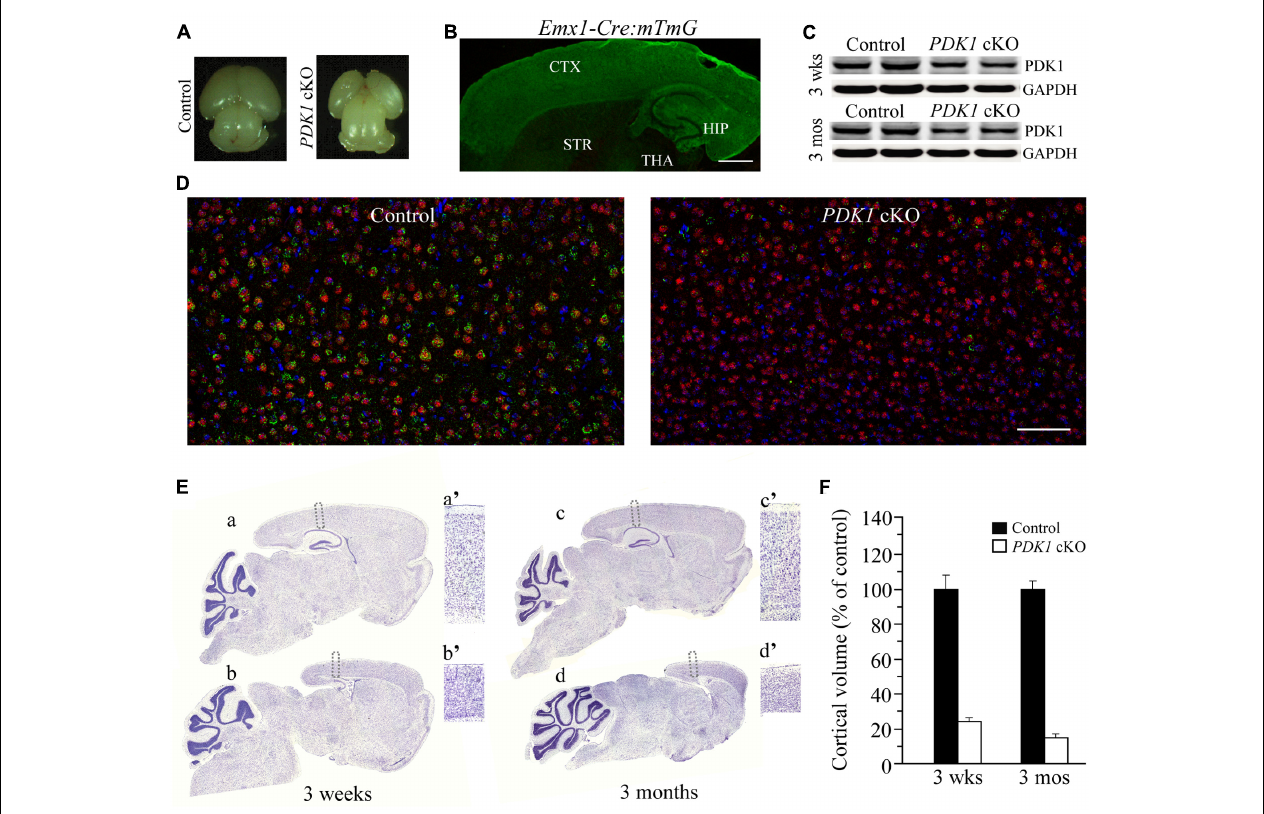
FIGURE 1 | Reduced size of the cortex in forebrain-specific PDK1 cKO mice. (A) Representative brain photos for a control mouse and a PDK1 cKO mouse at P0. (B) The expression pattern of GFP in the brain of a 3-week-old Emx1-Cre;mTmG mouse. GFP was mainly expressed in the cortex (CTX) and the hippocampus (HIP) but not the striatum (STR), the thalamus (THA), or the cerebellum. (C) Western analysis on PDK1. Cortical homogenates from mice aged at 3 weeks and 3 months ( n = 3–4/group/age) were prepared. There was significant difference on protein levels of PDK1 between control and PDK1 cKO mice (3 weeks: control = 100 ± 4.6%, cKO = 58.0 ± 5.8%; 3 months: control = 100 ± 3.5%, cKO = 60.3 ± 2.1%; p s < 0.005). GAPDH served as the loading control. (D) Double-immunostaining for NeuN/PDK1 in mice at 3 weeks of age. Most NeuN+ cells in control brain were PDK1+ but very few NeuN+ cells in PDK1 cKO brain were PDK1+. Scale bar = 100 µ m. (E) Nissl staining for mice at 3 weeks and 3 months. Boxed areas in control (a,c) and cKO (b,d) were enlarged as a’, c’, b’, and d’, respectively. (F) Relative cortical volume. There was significant difference on the size of the cortex between control and PDK1 cKO mice at 3 weeks (control = 100 ±